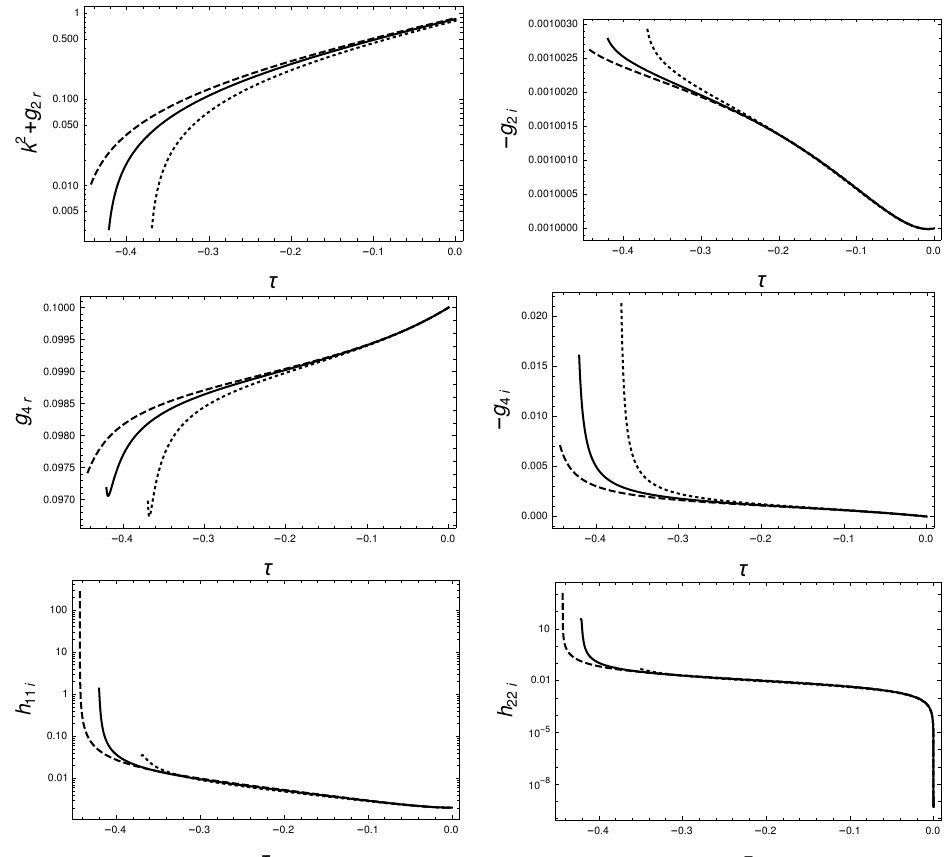
Figure 7. Zooming into the SB − SB E phase boundary. The trajectories in the SB (dotted line) and SB E (dashed line) phases together with the separatrix (continuous line) belong to the initial conditions g 2 r ( Λ ) = − 0.12 (dashed line), g 2 r ( Λ ) = − 0.141 (solid line), g 2 r ( Λ ) = − 0.18 (dotted line), g 2 i ( Λ ) = − 0.001, g 4 ( Λ ) = 0.1, h 11 ( Λ ) = − i 2 g 2 i ( Λ ) , h 22 ( Λ ) = 0 and η =